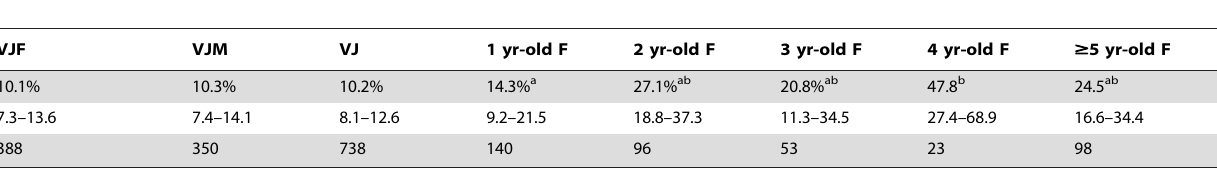
Proportions with superscripts in common for adult ( $ 1 year old) bats are not significantly different ( P . 0.05). Values are seroprevalence (% seropositive), 95% confidence interval for seroprevalence, and sample size (number of unique individuals sampled). Abbreviations: F= female, M=male, VJ=volant juvenile.